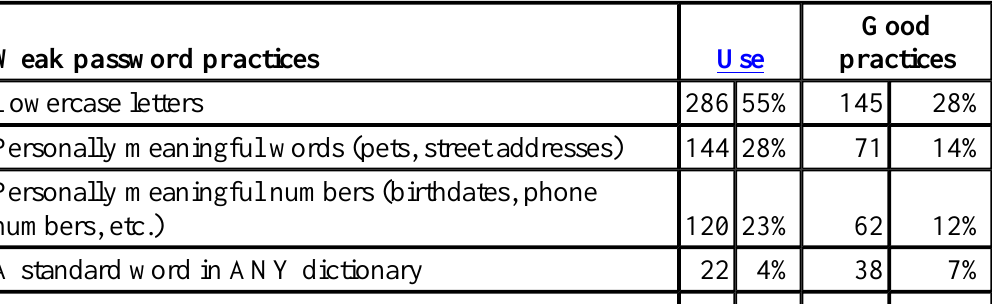
Table 5 Password practices in selecting a password: Use and good